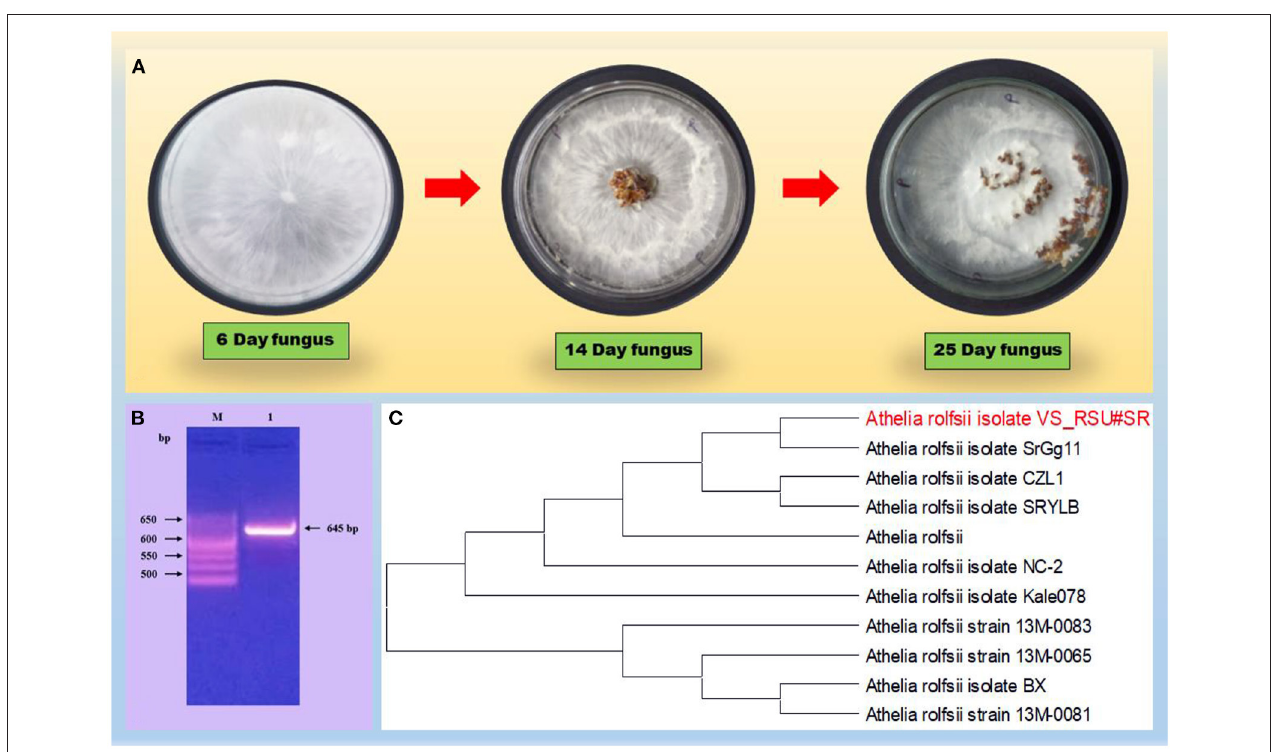
FIGURE 1 | (A) Describes the morphology of the fungus on PDA plate. (B) Gel electrophoresis of the PCR product with primers, ITS1/ITS4 of DNA from the fun-gal isolate. Lane M, molecular weight markers (1kb ladder); lanes 1, Athelia rolfsii (645 bp); (C) Phylogenetic tree on a fungal strain, the Athelia rolfsii isolate, based on the 18S rDNA gene sequence. A boot strap consensus tree was drawn by multiple sequence alignment with a method using neighbor-joining software, MEGA X.